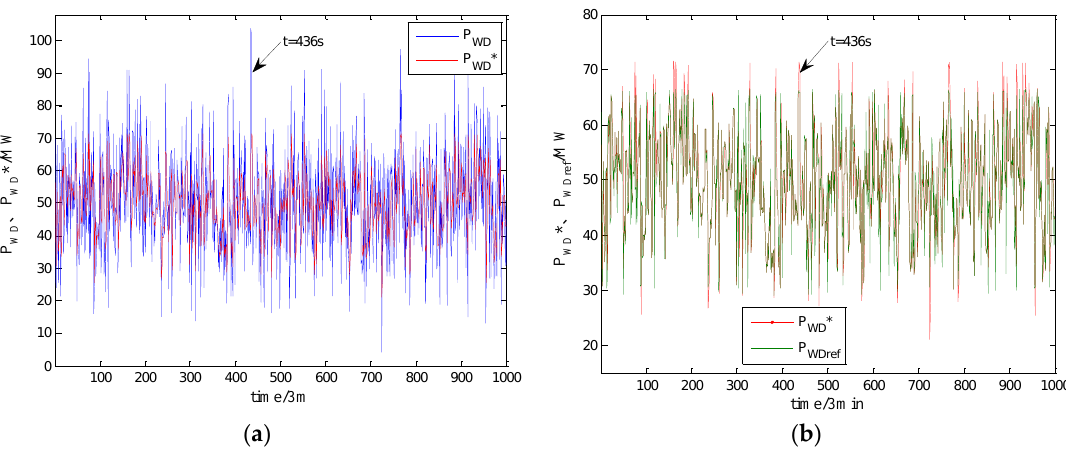
Figure 6. Compensation effect on wind power output by HESS. ( a ) Comparison between P WD and P WD * ; ( b ) comparison between P WD * and P WDref .